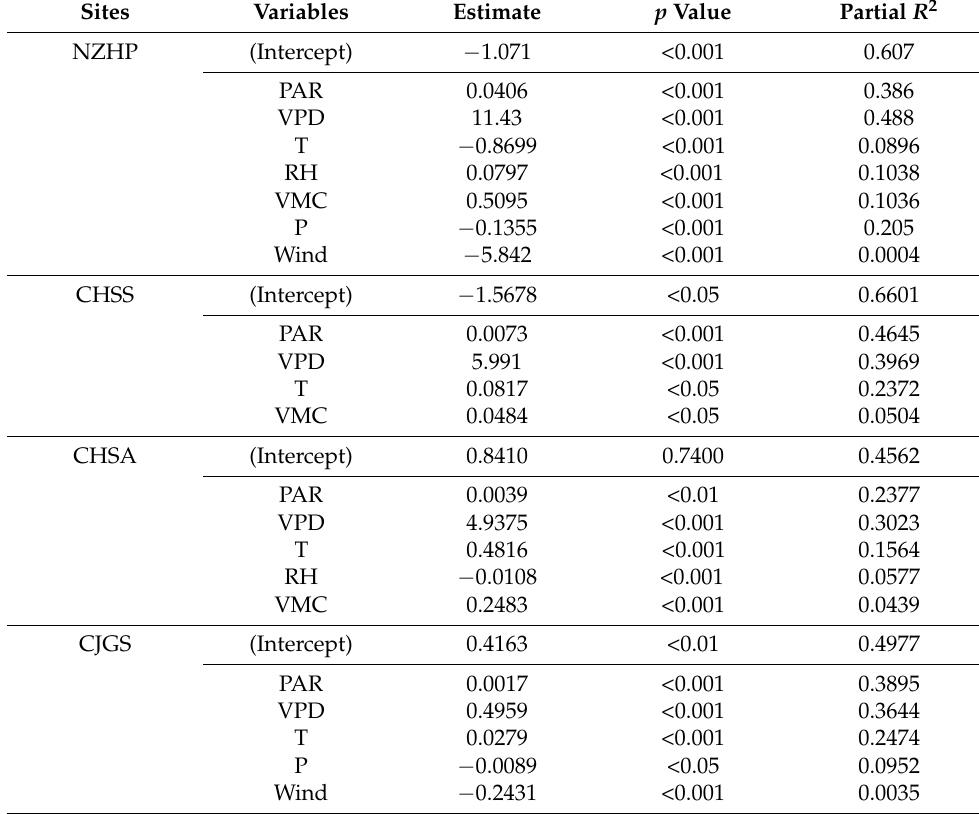
Table 5. Results of multiple linear regression for daily whole tree water use over two years of study period at each site. Daily PAR, daily VPD, daily temperature, daily RH, total rain, wind speed and daily VMC (if available) are shown. For JGS, we used average whole tree water use for three species here because of the weak relationship between predicted variables and whole tree water use.